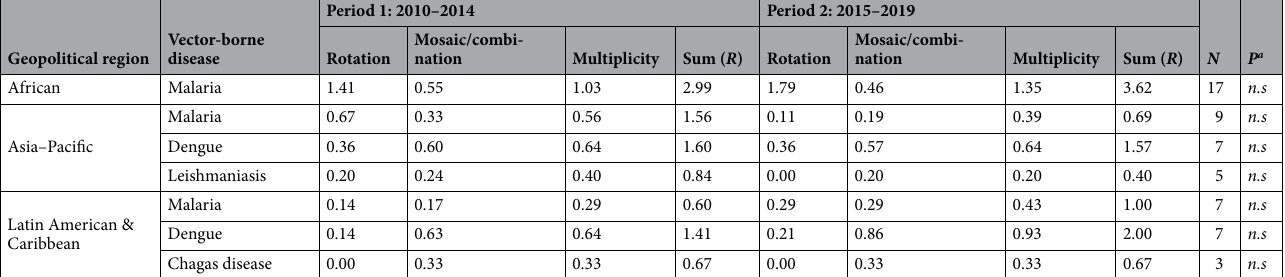
Table 2. Degree of proactive resistance management for disease vector control. Values are shown of parameter R and its components of rotation, mosaic/combination spraying, and multiplicity of modes of action, in eligible countries ( N ) during two 5-year periods. n.s ., not significant ( P > 0.05). a Paired t-test (two-tailed) of R -values between the two